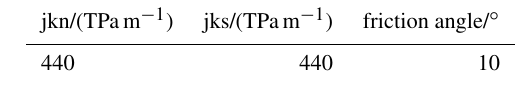
Table 12. Constitutive parameters for interfaces.